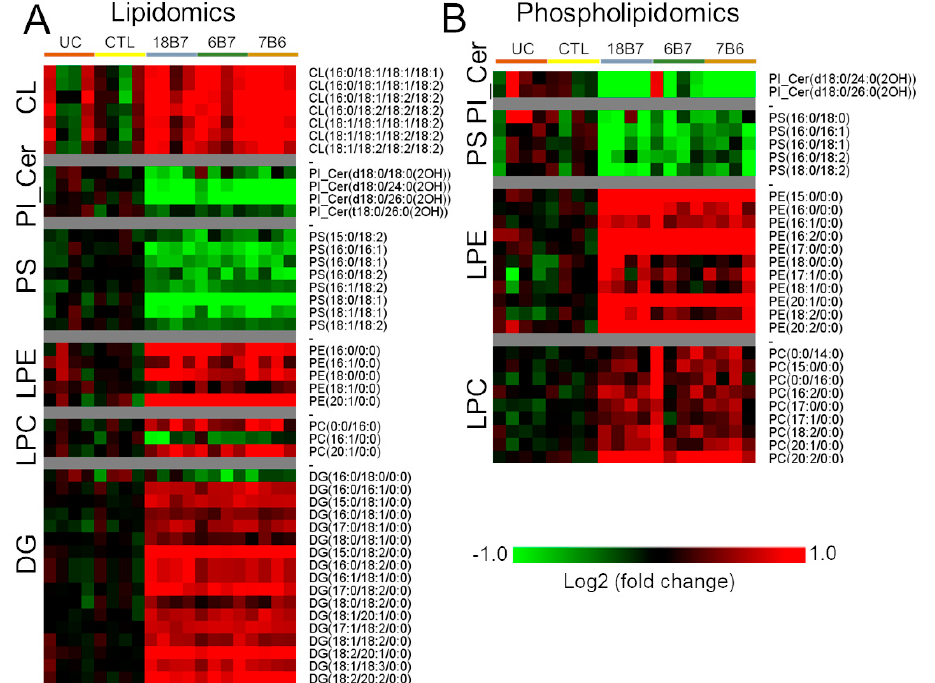
Figure 4. Regulation of different lipid classes in H. capsulatum cells by monoclonal antibody treatment. ( A ) Heatmap of significantly regulated cardiolipins (CL), inositolphosphoceramides (PI_Cer), phosphatidylserines (PS) and lysophosphatidylethanolamines (LPE), lysophosphatidylcholines (LPC) and diacylglycerols (DG) detected in the lipidomics analysis of H. capsulatum cells treated with monoclonal antibodies 18B7, 6B7 and 7B6. ( B ) Heatmap of significantly regulated PI_Cer, PS, LPE and LPC species detected in the phospholipidomics analysis of H. capsulatum cells treated with monoclonal antibodies 18B7, 6B7 or 7B6. Abbreviations: CTL, control; UC, untreated control without hybridoma medium.